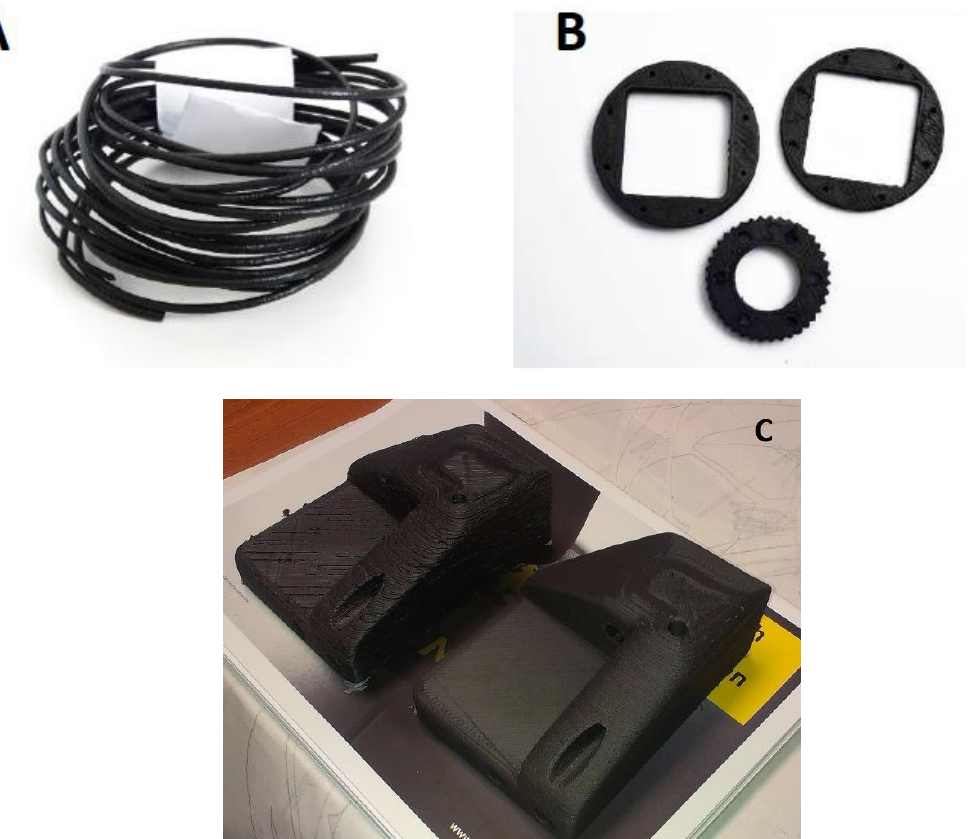
Figure 4. ( A ) Prepared PETG composite filament, ( B ) 3D printed component, ( C ) 3D printed large printer pad, left—from commercial CF/PETG filament, right—hybrid filament from recycled PETG.